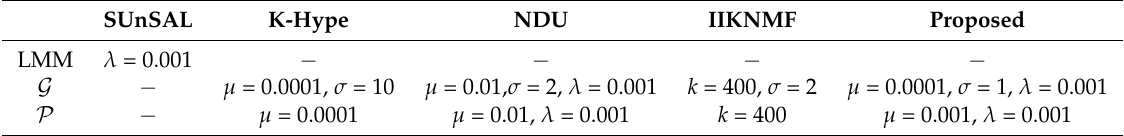
Table A4. Parameters used in algorithms of S 7